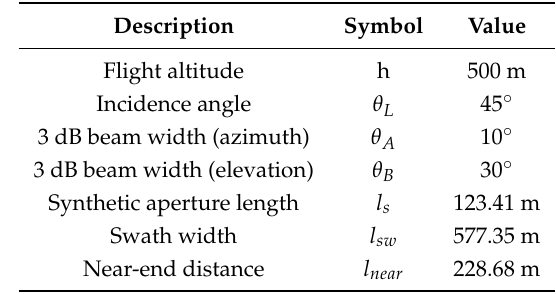
Table 1. SAR system parameters.